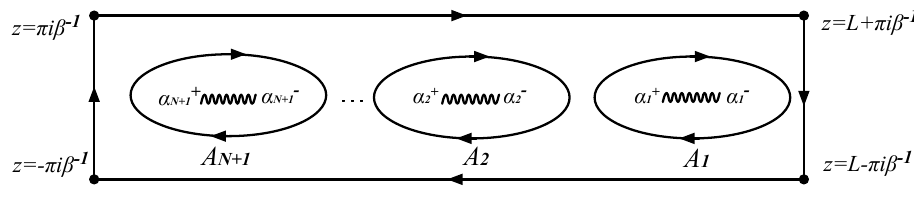
Figure 17 . Contour integral related to boundary